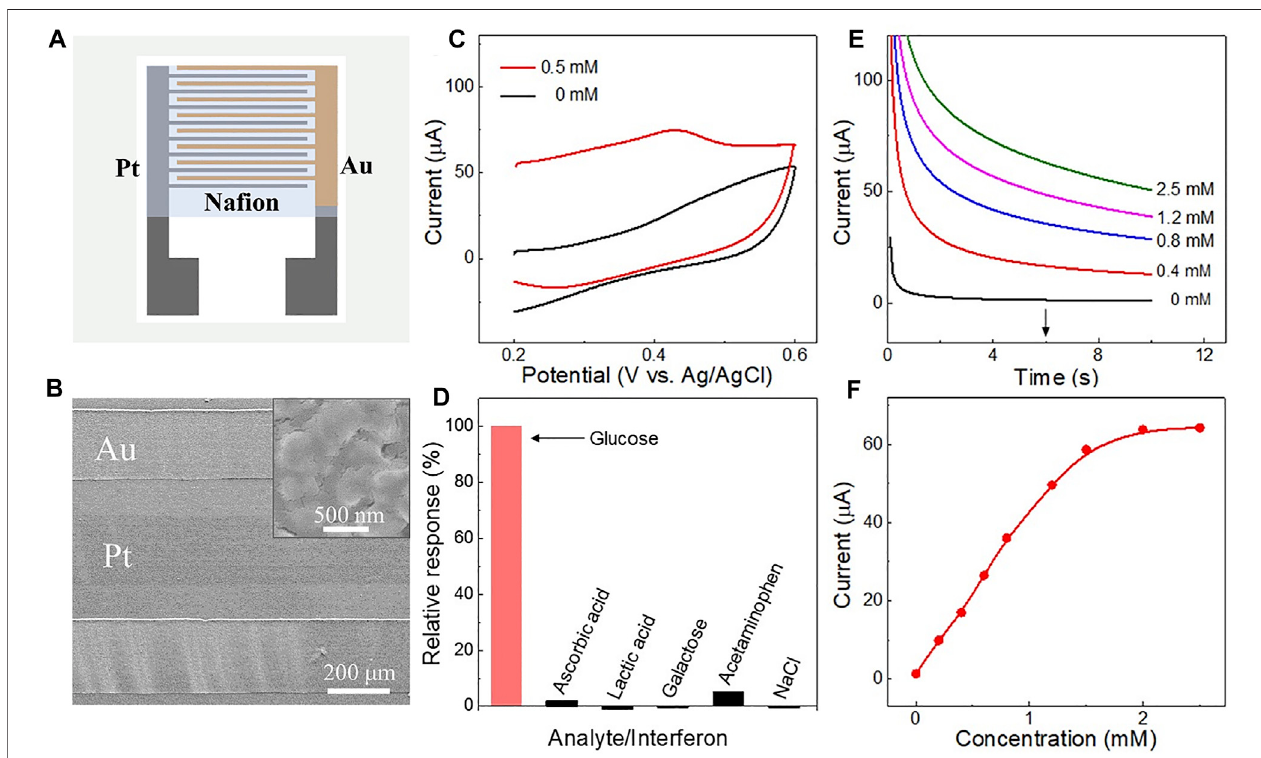
FIGURE5|(A) SchematicoftheNa fi onlayeronthePt-Auelectrodesurface. (B) SEMimageoftheNa fi on fi lm-coatedelectrode.Theinsetisanenlargedviewofthe surface of the Au electrode. (C) Cyclic voltammetry curves obtained ina 0.1 M Na 2 SO 4 solution with or without 0.5 mM glucose, using the na fi on-coated triphase Pt-Au electrode,respectively. (D) Histogramoftheinterferenceeffectsontheelectrodewhilemeasuring0.5 mMglucoseat0.4 V vs .Ag/AgCl.Theconcentrationofinterferents was0.05 mM,includingascorbicacid,lacticacid,galactose,acetaminophenandsodiumchloride(NaCl). (E) Amperometrici-tcurvescorrespondingtothena fi on- coated electrode with glucose concentrations up to 2.5 mM. (F) Corresponding calibration plots of na fi on-coated triphase electrode derived from (E) at 6